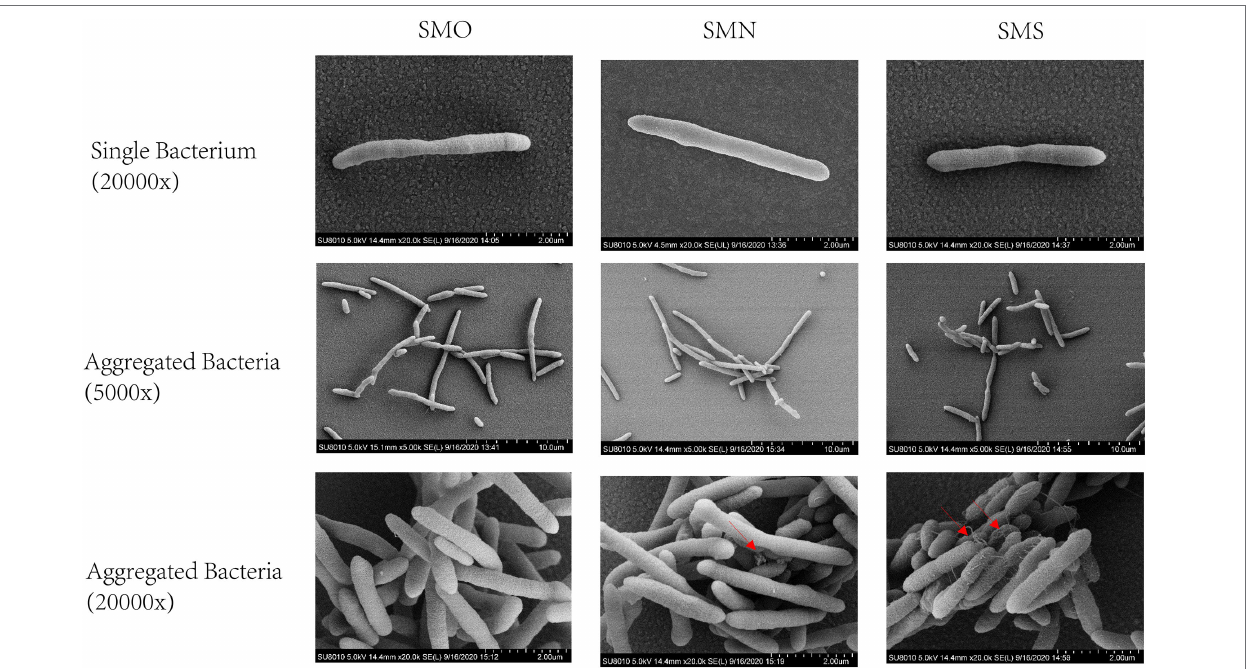
FIGURE 2 | Scanning electron micrographs (SEM) images of Stenotrophomonas maltophilia . The red arrow indicates the intercellular mucus-like substances. The first row showed the morphology of single bacterium under 20,000x SEM. The middle row showed the morphology of aggregated bacteria under 5,000x SEM. The last row showed the morphology of aggregated bacteria under 20,000x SEM.